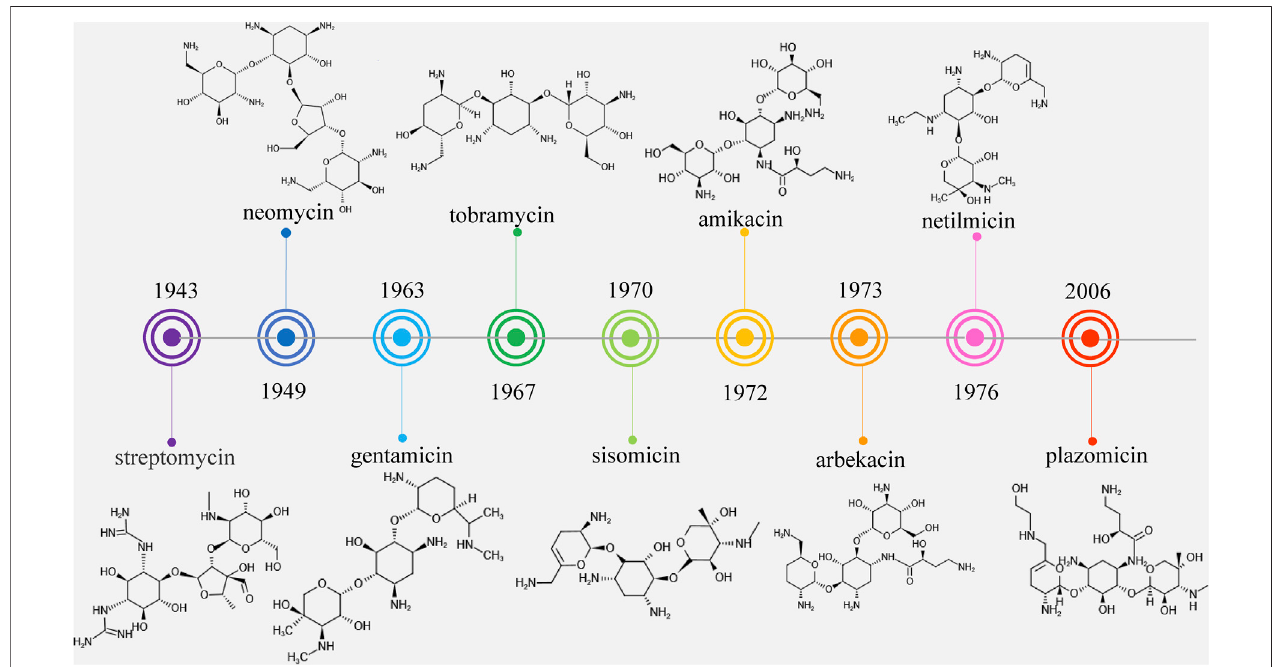
FIGURE 1 | Timeline of aminoglycoside antibiotics development.